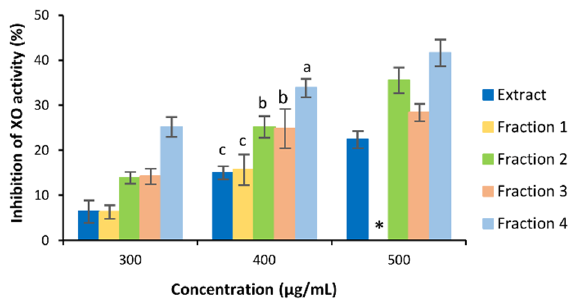
Figure 4. Xanthine oxidase (XO) inhibitory activity of a green Cyclopia subternata hot water extract and four fractions from large-scale fractionation on XAD 1180N as a function of sample concentration. Data are given as mean ± standard deviation (n = 3). Different letters above bars indicate significant differences ( p < 0.05) at 400 µg/mL. * Value not available due to background absorbance of the fraction at this concentration.